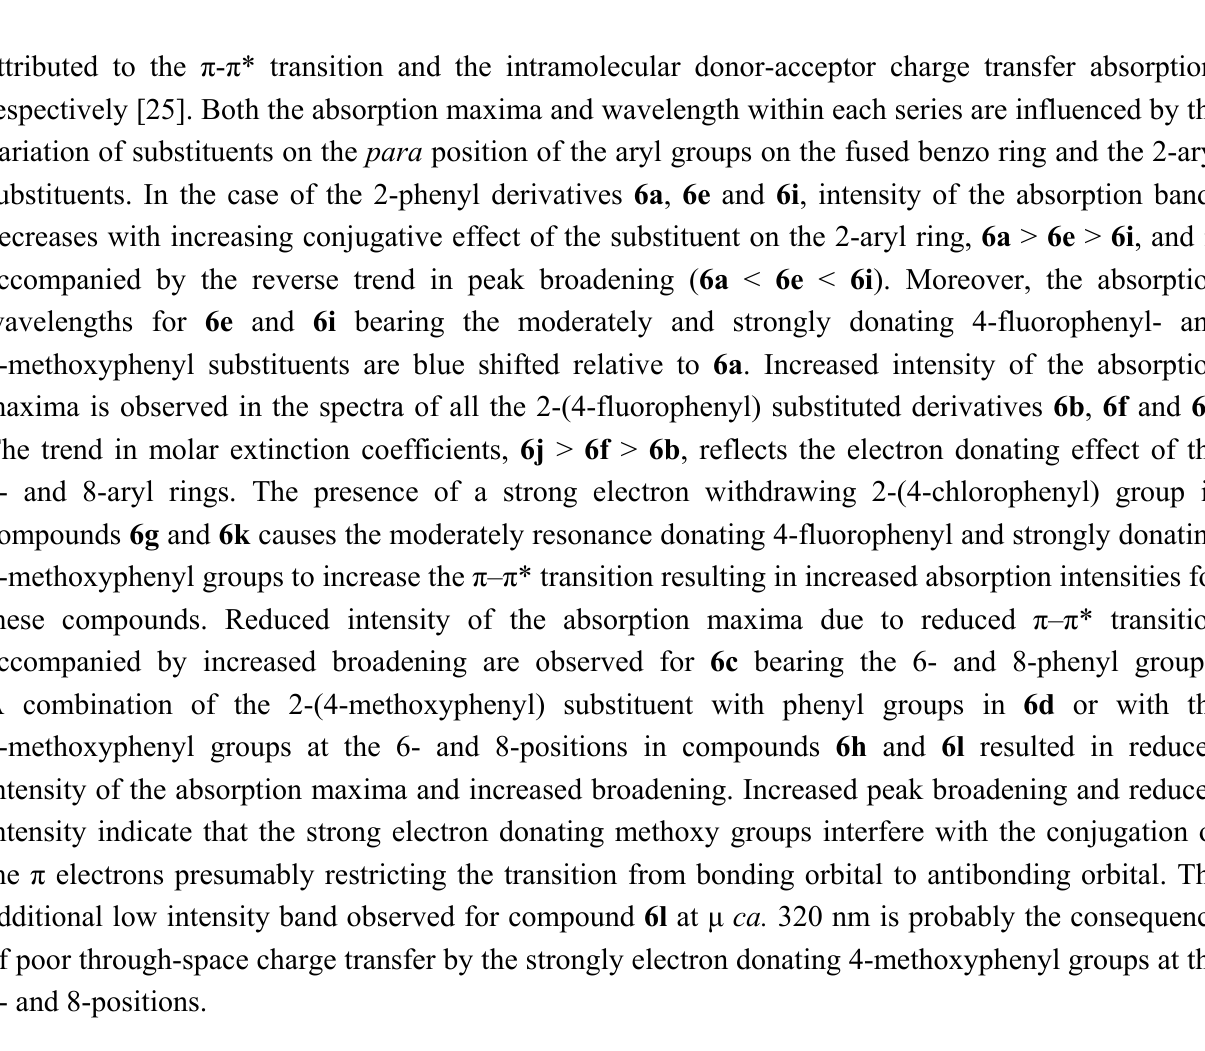
Figure 1. UV-Vis spectra of 6a – d in CHCl